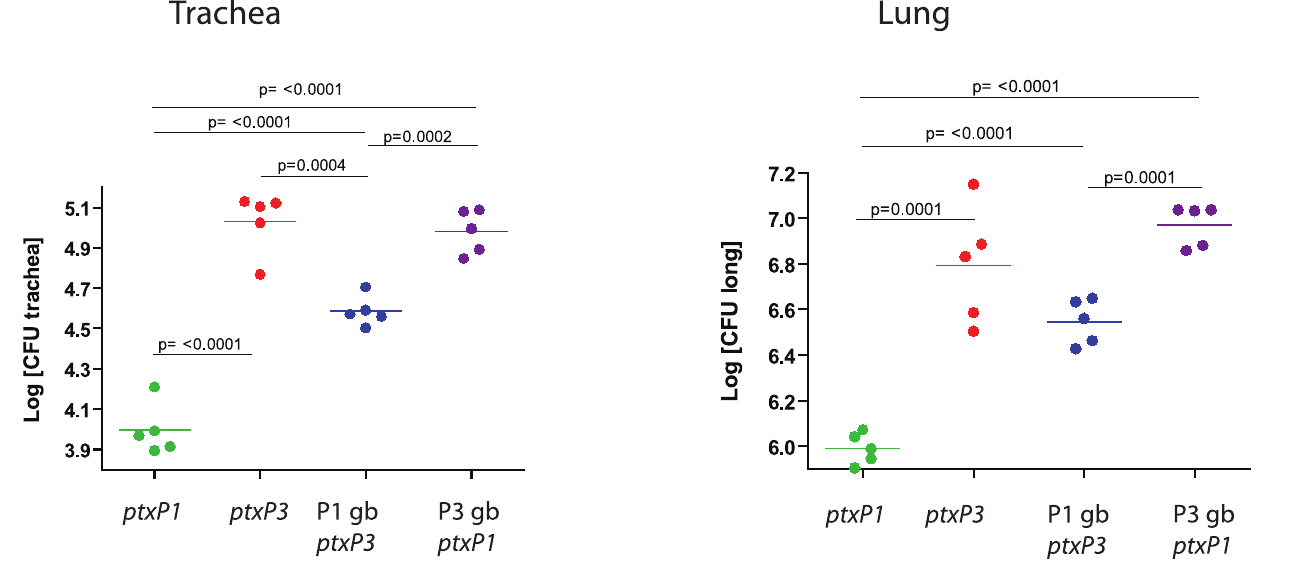
Figure 3. Role of the ptxP3 and ptxP1 mutations and the genetic background of ptxP1 and ptxP3 strains in colonizing the trachea (A) and lungs (B) in mice. Mice were intranasally infected with the wildtype ptxP1 strain, the ptxP3 strain, isogenic strains carrying the ptxP3 allele in the ptxP1 genetic background (P1 gb: ptxP3 ) or the ptxP1 allele in the ptxP3 genetic background (P3 gb: ptxP1 ). CFUs were determined in the trachea and lungs four days post-infection. The mean is indicated by a thin line. P-values (uncorrected for multiple tests) were shown if greater than 0.05. The experiment was performed two times representative result is shown.